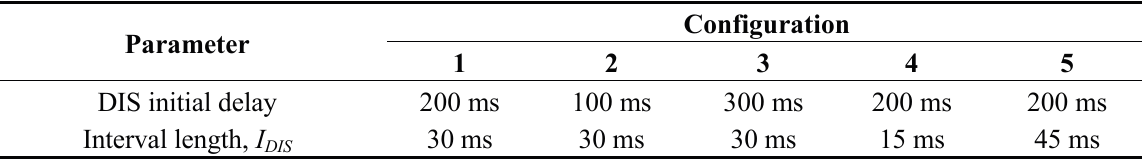
Table 4. DIS-Trickle parameter configurations